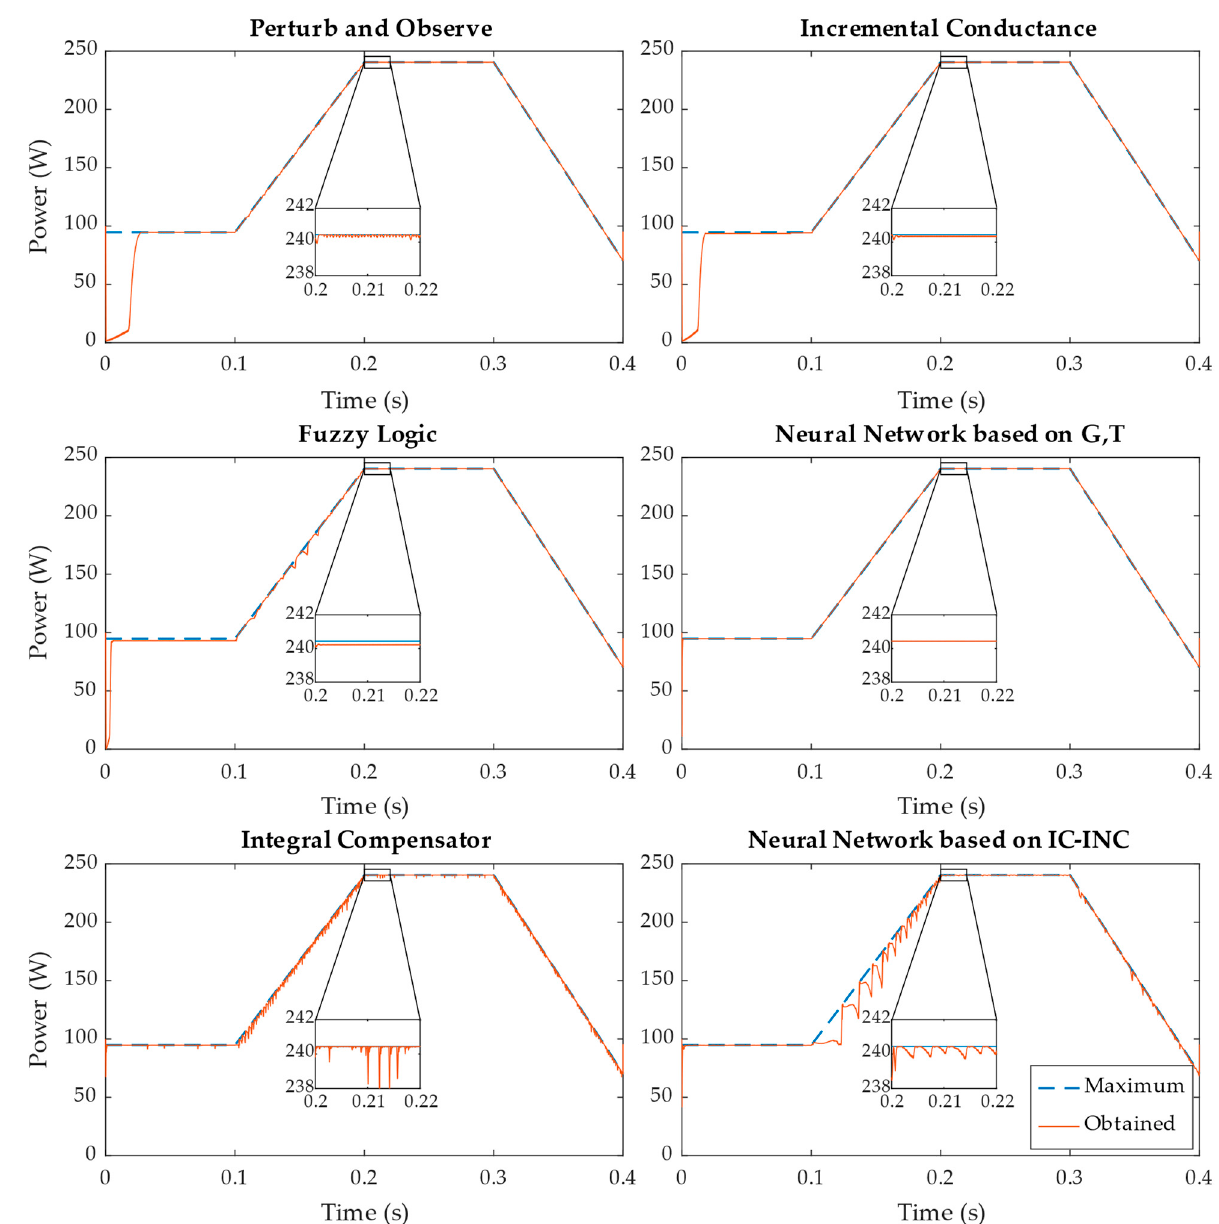
Figure 15. Simulation results of power produced from panel when fast variations occurred.